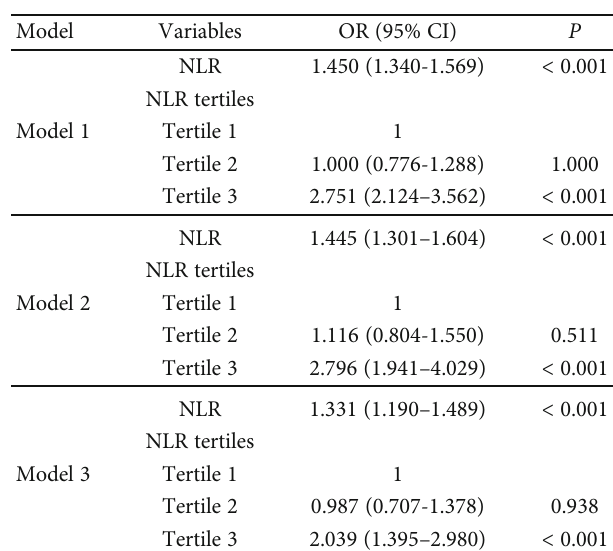
Table 4: Multivariate logistic regression analysis for prediction of neonatal sepsis.